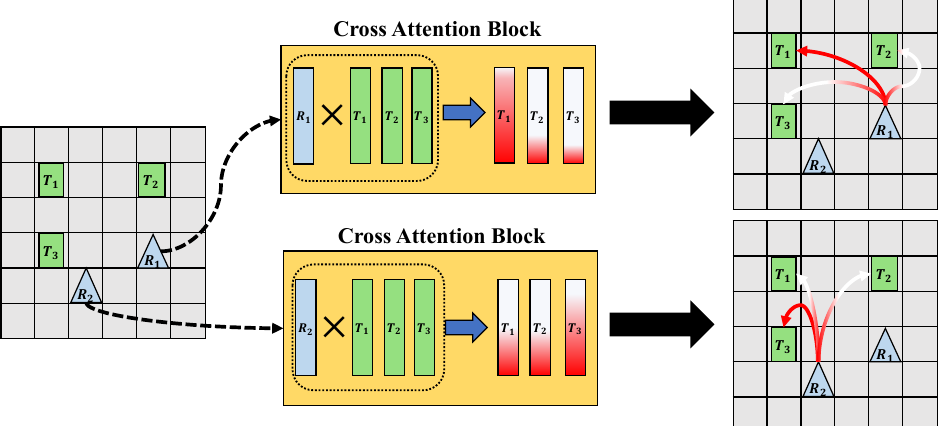
Figure 4. What the model learns. The representation of robots and tasks includes the relationship information between robots and tasks. In this figure, T 1 is the most important task for the robot R 1 and T 3 is the most important task for the robot R 2 . The rectangle blocks in the cross-attention block are the vector representation of robot and task. The gradient on color denotes the importance of the task. More red is more